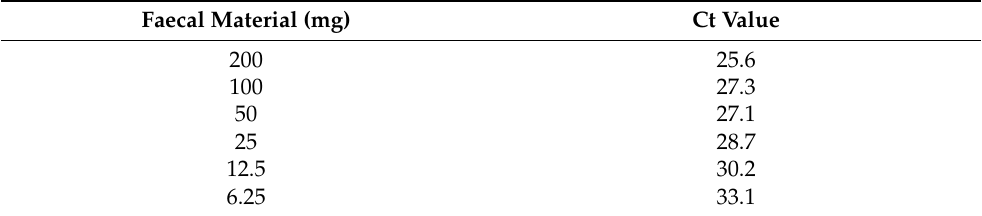
Table 2. Cycle threshold (Ct) values obtained by real-time PCR in serially-halved amounts of a faecal sample positive for G. duodenalis impregnated in Whatman ® FTA ® Classic Cards. Faecal Material